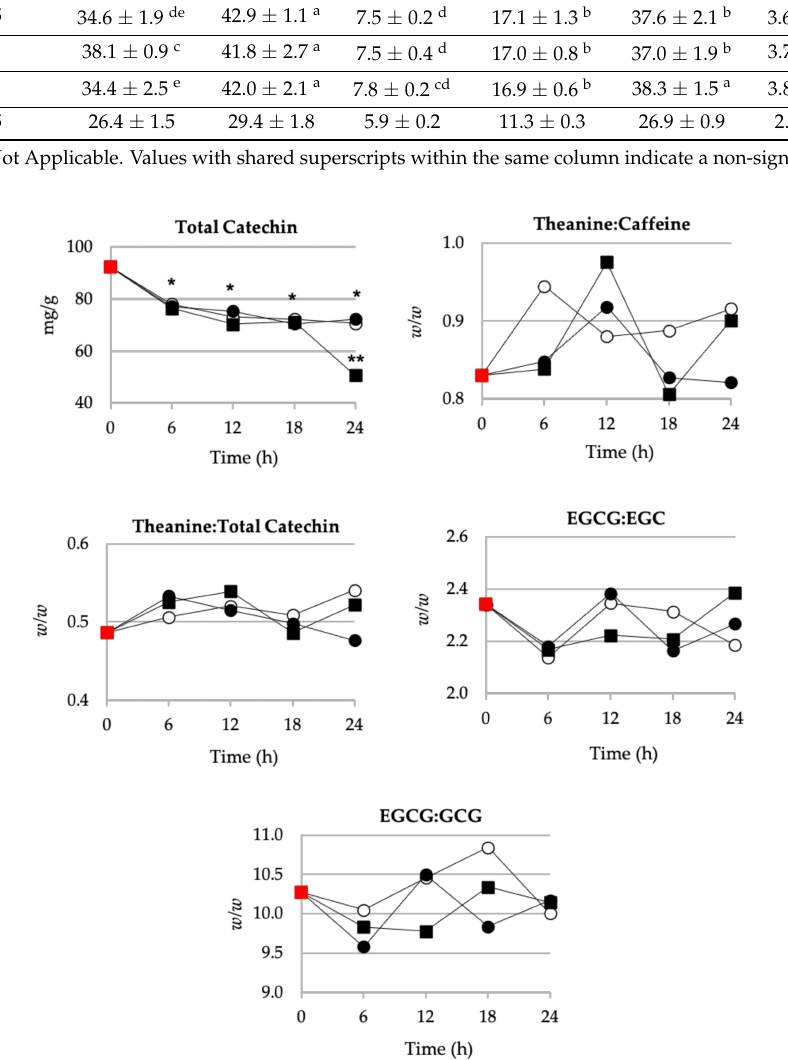
Figure 3. Line graph of mean effect on the concentration of QM’s elicited by post-harvest processing delays (6, 12, 18 and 24 h) and variations in storage temperatures (white circle: 0 ◦ C; black circle: 5 ◦ C; black square: 25 ◦ C). A single asterisk indicates a significant difference ( p < 0.01) between each time delay condition vs. the control (red square: control), and a double asterisk indicates a significant difference ( p < 0.01) between storage temperature vs. the control (red square: